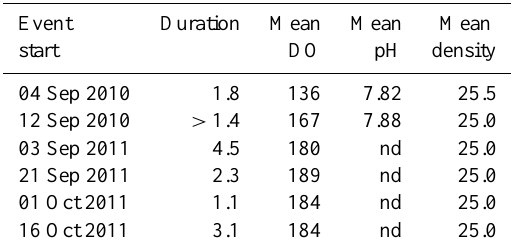
Table 2. Low dissolved oxygen ( 1 DO) and pH ( 1 pH) events at 7m water depth at mooring A. Event start date is day that low- pass filtered DO and pH fell below 200µmolkg − 1 and 7.9units, respectively. nd=no data.